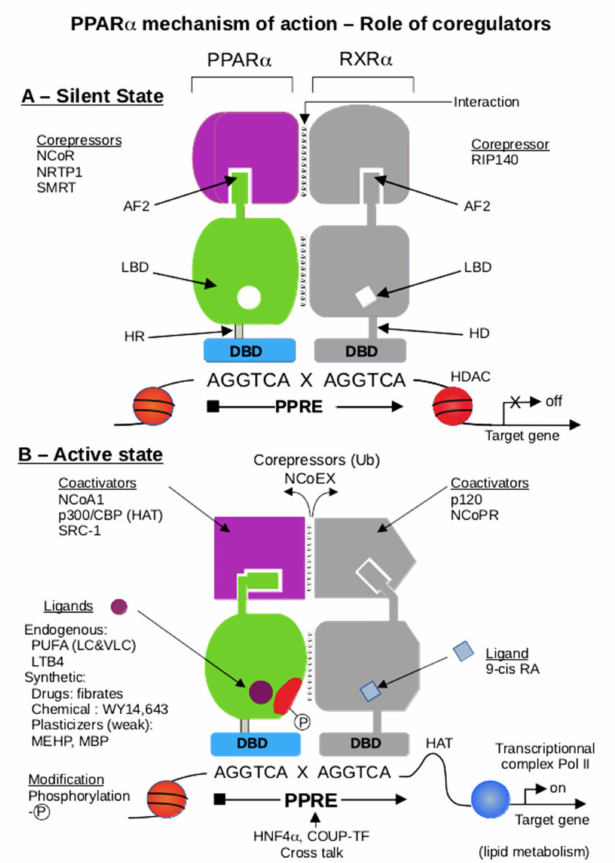
Figure 6. Scheme of heterodimer PPAR α /RXR α , located on a PPRE DNA region. The graphic displays two parts: part ( A ), the silent state, and part ( B ), the active state. Part ( A ). In the absence of the ligand, PPAR α interacts with transcriptional corepressors (NCoR, SMRT, NRTR-P-1) by recognizing the AF2 region. The same process is at the RXR, where AF2 interacts with RIP140 as RXR α corepressor [169]. Due to the chromatin condensed state, the heterodimer cannot bind the PPRE properly. Part ( B ). In the presence of a PPAR α ligand, either a long-chain or very-long-chain polyunsaturated fatty acid, leukotriene LTB4, fibrate or other chemicals [170], and a 9-cis retinoic acid as RXR α ligand, an exchange corepressor/coactivator is made by NCoEX, which suppresses the repressive of corepressor state by ubiquitinylation-inducing degradation by the proteasome system. The fixation of a ligand induces an allosteric LBD conformational change of AF2, allowing the recruitment of coactivators, either NCoR1, p300/CBP, or SRC1 for PPAR α , and p120 and NCoPR for RXR α [171]. The CBP-dependent HAT activity induces the remodeling of chromatin and allows the PPAR α /RXR α heterodimer to bind to PPRE correctly, then activates the Pol II transcription complex and triggers the transcription of lipid metabolism-encoding genes. Some